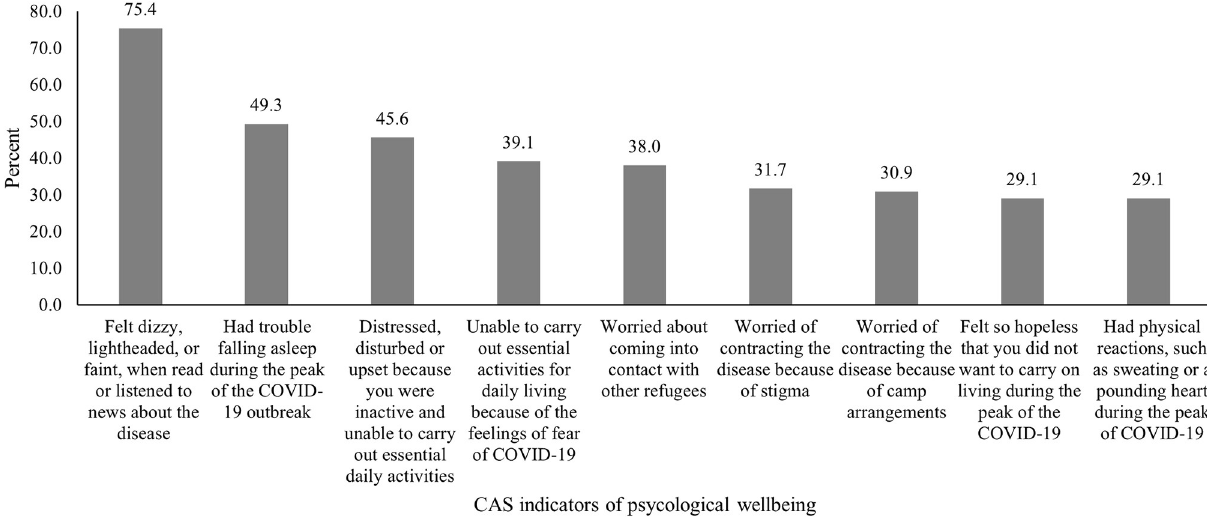
Fig 1. Percentage distribution of respondents by CAS indicators of psychological wellbeing.